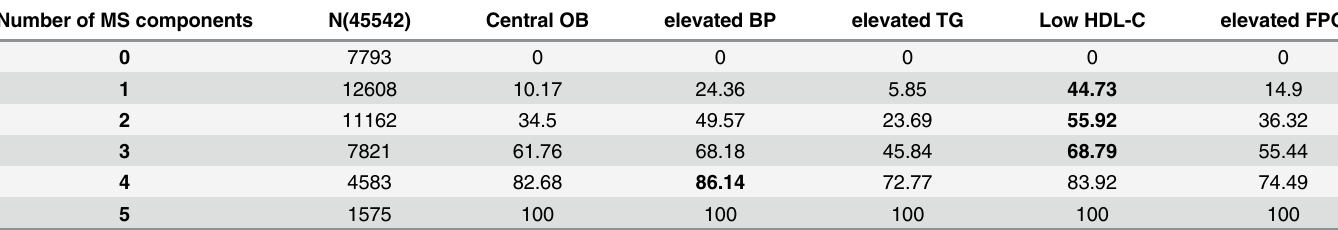
Table 2. Distribution of the study subjects among different number of MS